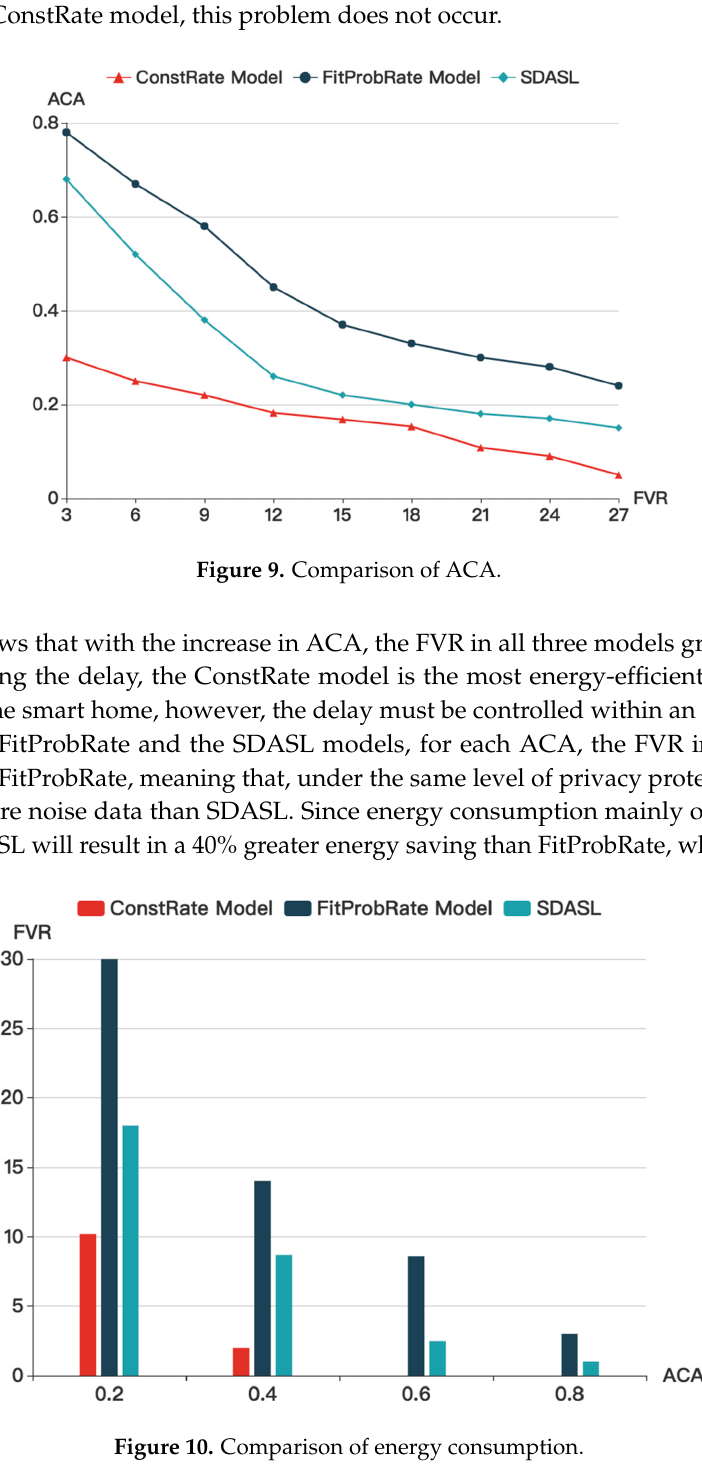
Figure 8. Comparison of latency; ( a ) Description of the change of the Latency which with the change of the FVR; ( b ) Description of the change of Latency of FitProbRate Model which with the change of the hours in a day.